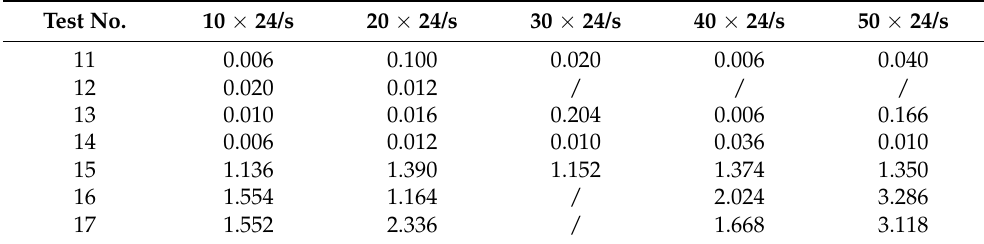
Table 3. Detection delay of LSTM-GAN having different sample